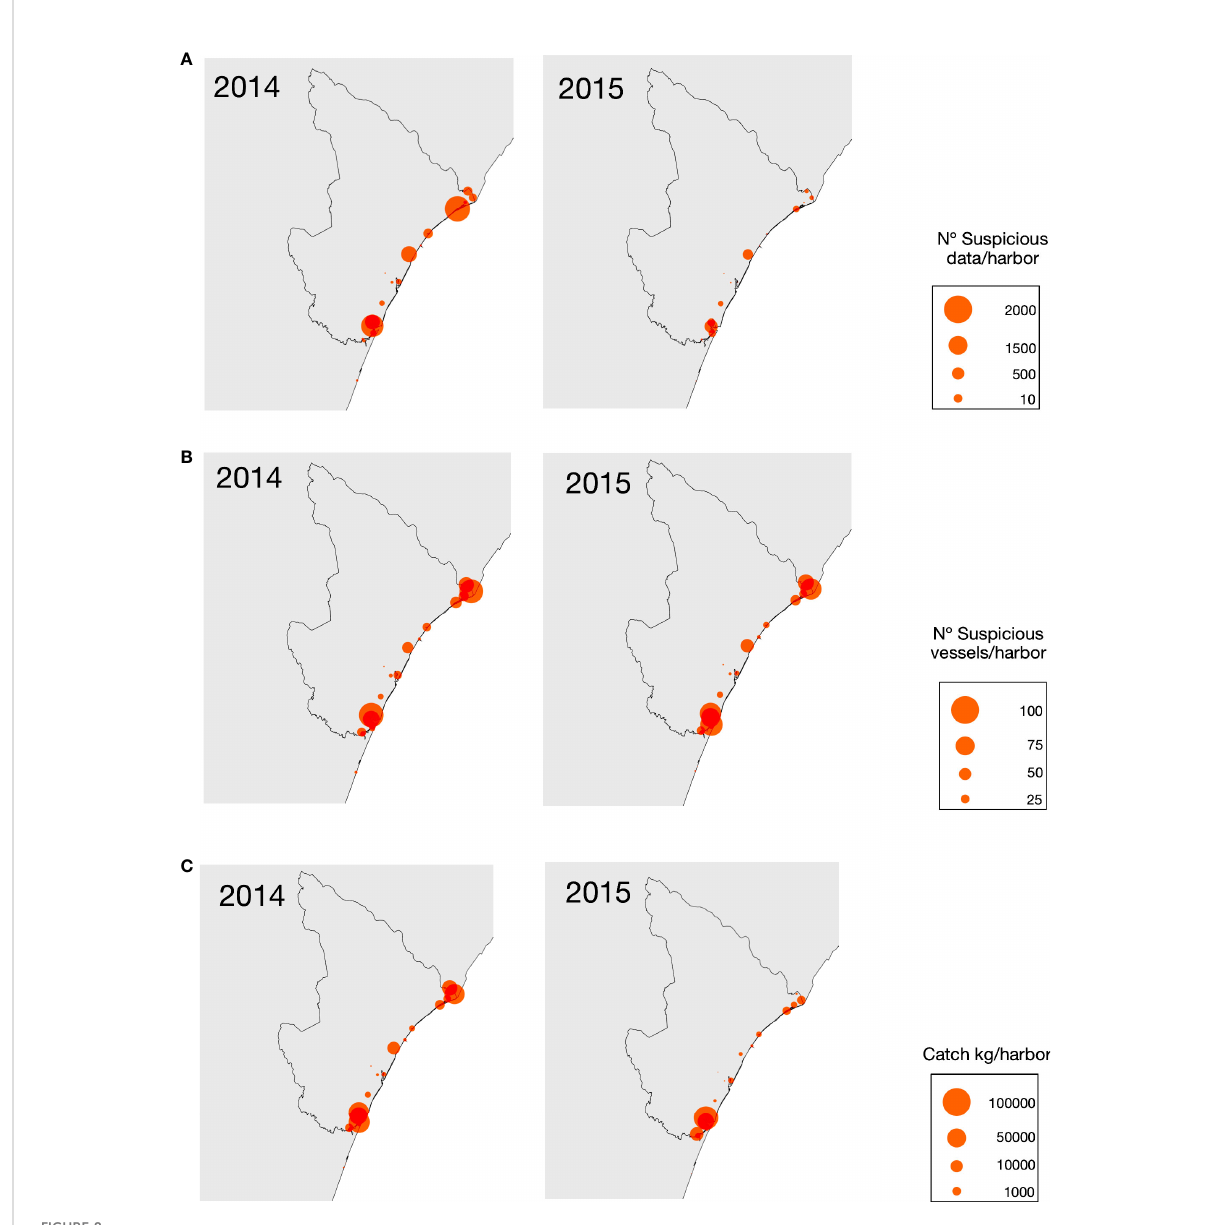
FIGURE 8 Scatter map of suspicious data of motorized canoes (A) , suspicious vessels (B) , and total catch (C) for each harbor in 3 years of the study. Circle size is related to the magnitude of the number of suspect data, suspect vessels, and catch size